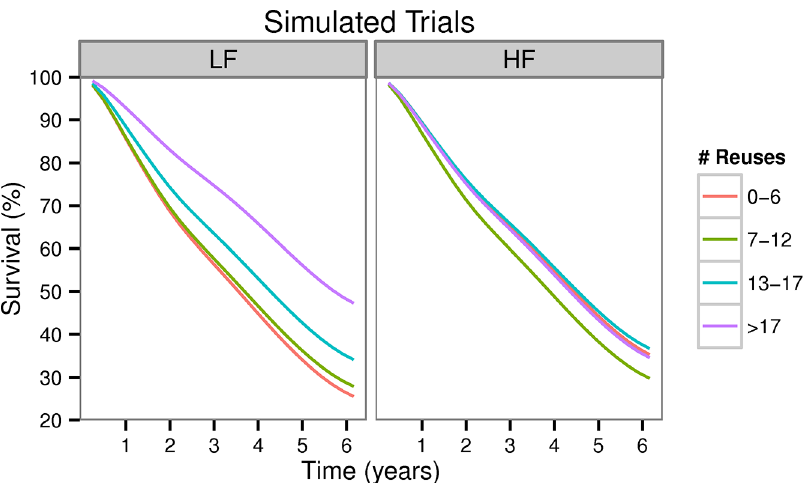
Fig 4. Predicted survival curves obtained by dynamic simulations of Joint Models. These were derived by counterfactually exposing HEMO study participants to all possible flux and reuse combinations. Individual survival probability curves were averaged at each observation point and these population averaged curves are depicted separately for low flux(LF) and high flux(HF) dialysis. Five year survival probabilities (P5, estimate and 95% Credible Interval) were as follows: 33.8% (28.0%-39.4%), 36.1% (30.8%-41.0%), 42.4% (36.9%-47.8%) and 55.6% (49.3%-55.8%) for increasing reuse of LF membranes. P5 (estimates and